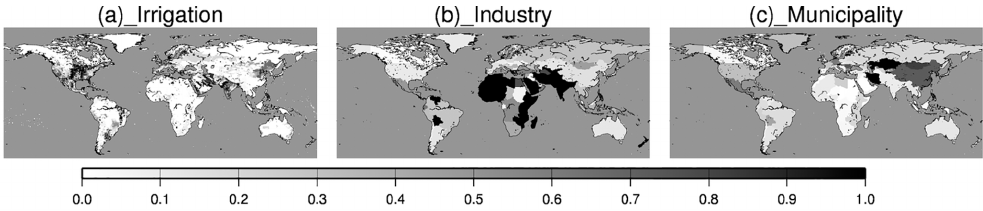
Figure 2. (a) The proportion of the irrigated area equipped with groundwater irrigation (from Siebert et al., 2010). The proportion of the water requirement assigned to groundwater for (b) industrial water and (c) municipal water (from IGRAC,